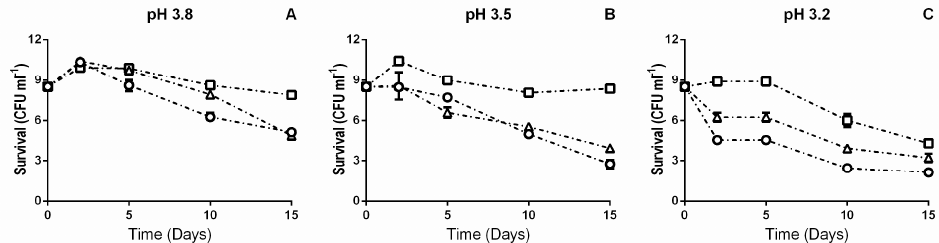
Figure 1. Survival of the Lactiplantibacillus plantarum strain UNQLp 11 (log CFU/mL) during fermentation in synthetic wine with different ethanol content (0% ( □ ), 12% ( ), and 14% v/v ( ○ )), at different pH values: 3.8 ( A ), 3.5 ( B ), and 3.2 ( C ).